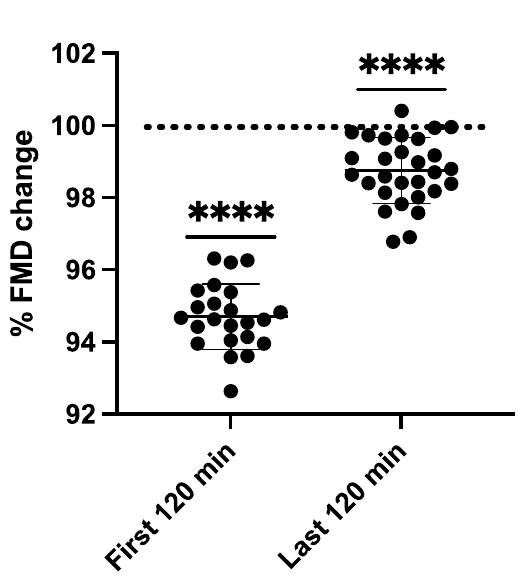
Figure 4. Bar graph illustrating FMD changes during the first 2 h (First 120 min.) ( n = 23) and last 2 h ( n = 29) (7–9 h) after saturation decompression (**** = p < 0.0001) (One sample t-test). (FMD Changes are presented compared to predive values represented by the dotted line at 100%).